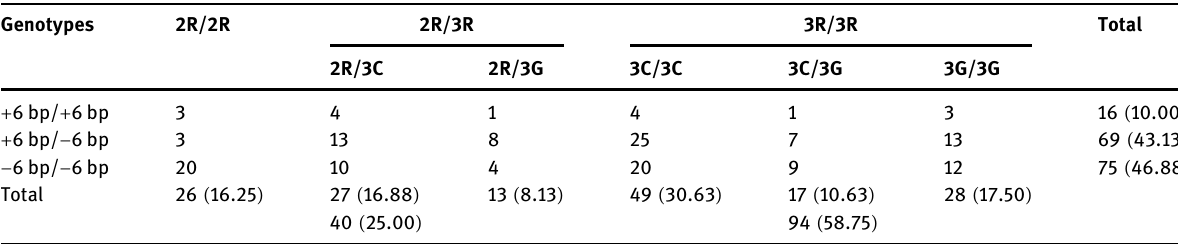
Table 2: The distribution of TS gene polymorphism in NSCLC patients